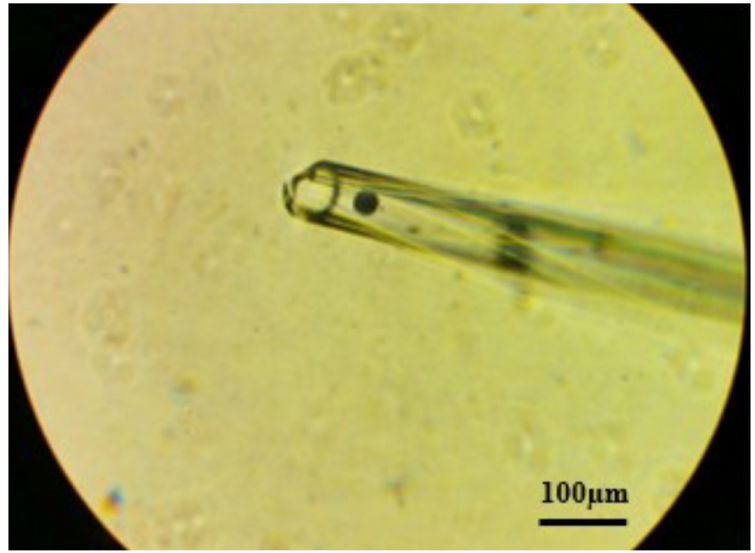
Figure 4. Melanophore captured in the pipette of a micromanipulator. The image was taken under a light microscope, 100 ×